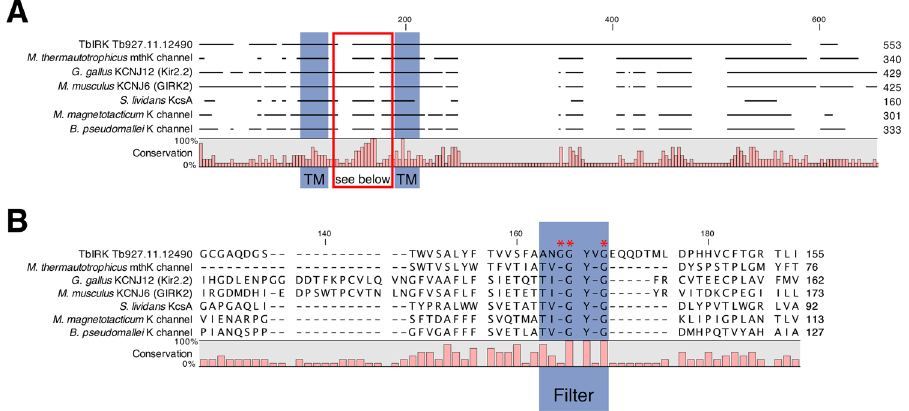
Figure 1. The unusual filter motif of TbIRK. ( A ) The protein sequence of TbIRK was aligned with representatives from six groups of similar proteins, as identified by HHBlits (Homology detection by iterative HMM-HMM comparison) within SWISS-MODEL 30 . Transmembrane domains unequivocally identified by different algorithms in all of the proteins are indicated in blue. The region between transmembrane domains is indicated by a red box. ( B ) Section indicated by the red box in ( A ), containing pore loop and filter motif, indicated in blue. Residues mutated within this study are indicated with a red